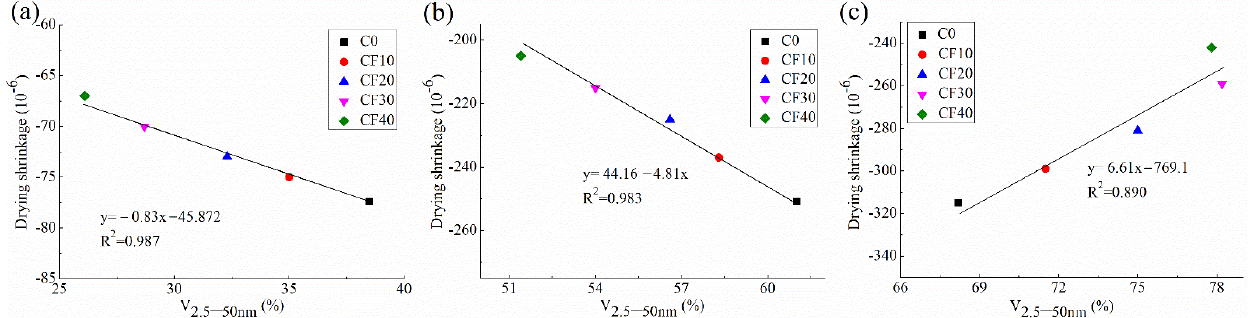
Figure 9. Correlations between drying shrinkage and V 2.5–50nm at ( a ) 3 days, ( b ) 28 days and ( c ) 180 days. ( c ) 180